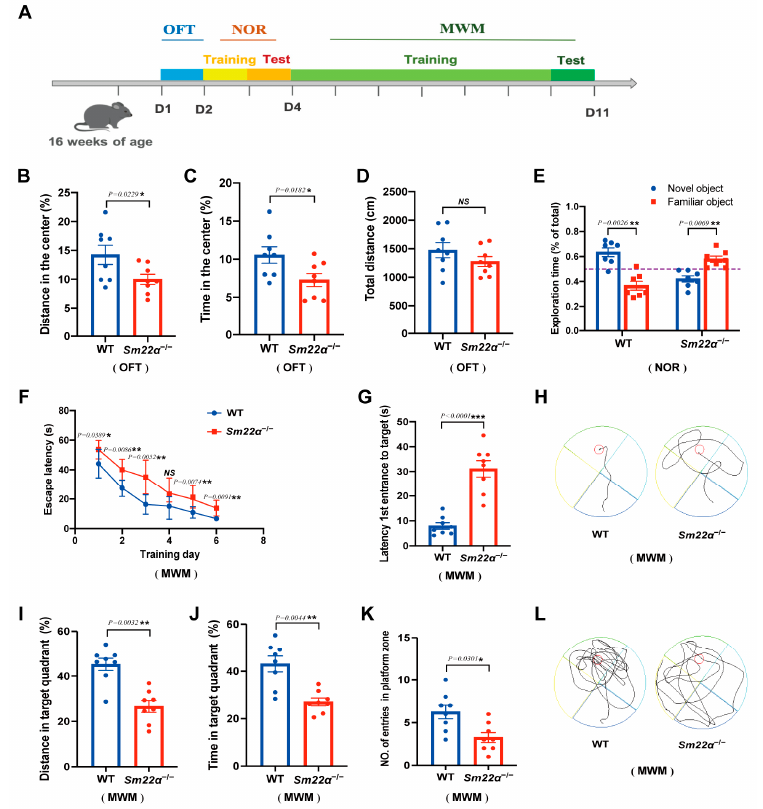
Figure 3. The Sm22 α − / − mice exhibited cognitive impairment. ( A ) Schematics of the experimental design for the cognitive behavioral study. OFT, open field test; NOR, novel object recognition test; MWN, Morris water maze test; D, day. ( B – D ) Performances in the OFT were recorded for 5 min. ( B ) Distance traveled in the center. ( C ) Time spent in the center. ( D ) Total travel distance. ( E ) Discrimination ratio of novel versus familiar objects during NOR. ( F – L ) Performances in the MWM during the training days and probe test. ( F ) Escape latency to the platform during the training days. ( G ) Latency to first reaching the platform and ( H ) representative track images of the mice in the probe test with the platform. ( I ) Distance in the target quadrant, ( J ) time spent in the target quadrant, ( K ) entry number in the platform zone, and ( L ) representative track images of the mice during the 60 s probe test without the platform. Data are represented as the mean ± SD ( n = 8 mice per group). * p < 0.05, ** p < 0.01, and *** p <